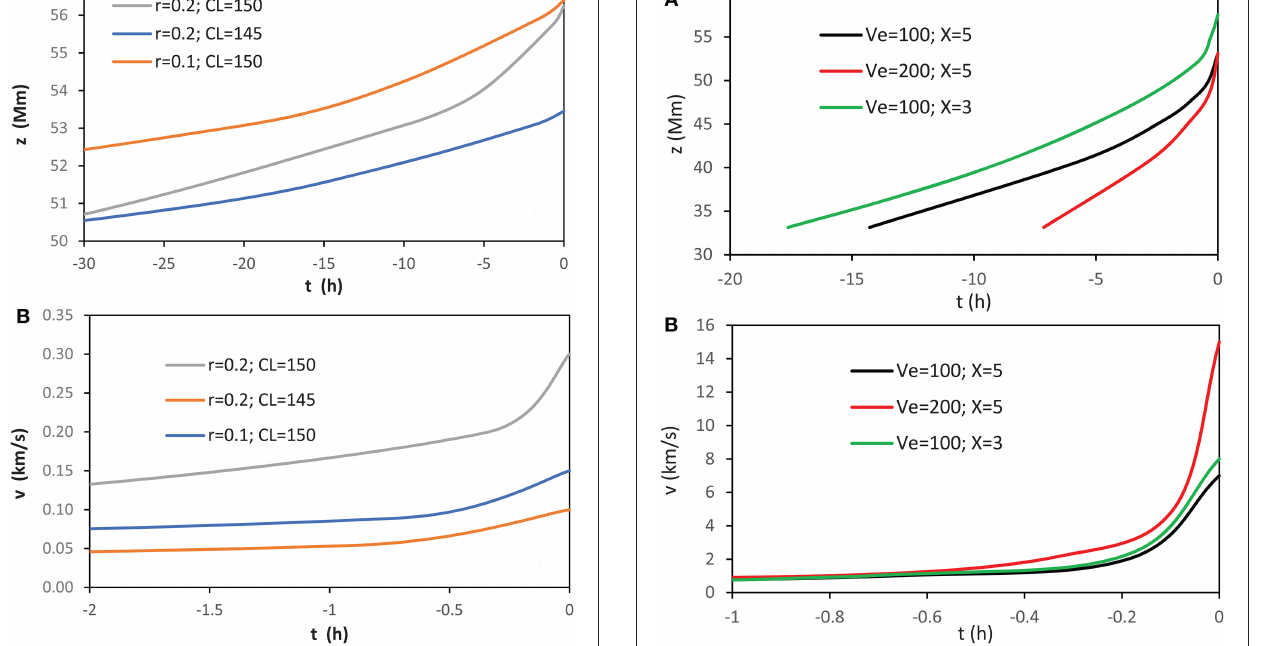
FIGURE 6 | Evolution of the flux rope caused by the poloidal flux injection, until the moment of the loss of equilibrium ( t = 0): (A) height–time; (B) velocity–time. The blue curve represents the case where the initial value of X is 3.5, whereas red and gray curves represent the case when it is 4.5. To better resolve the evolution of the rising speed, in the lower panel only a segment of 2 h before the eruption is presented. TABLE 1 | Comparison of the footpoint-twisting process and the emerging-flux process. (A) POLOIDAL-FLUX INJECTION (FOOTPOINT TWISTING)